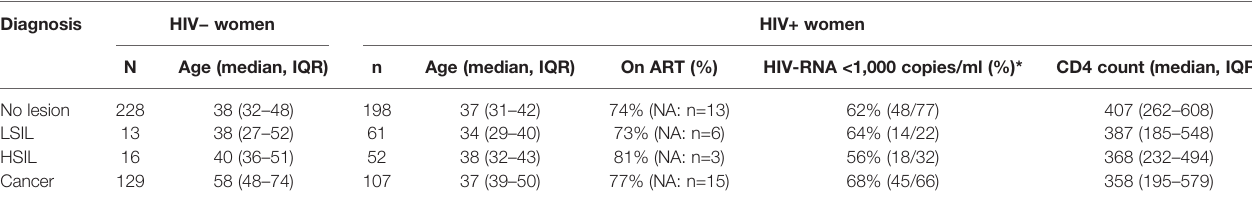
TABLE 1 | Summarizes the age and — for HIV-positive women — ART status, viremic suppression, and CD4 counts.